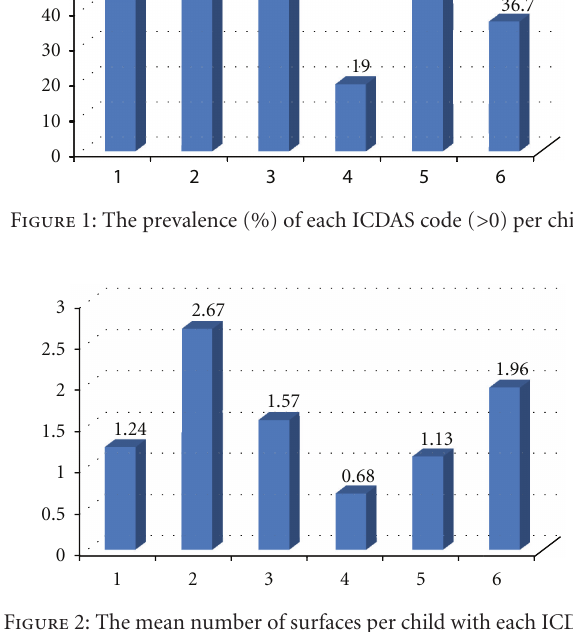
Table 2: The mean percentages of ICDAS codes in the upper and lower first permanent molars and second primary molars according to tooth surfaces. ICDAS codes